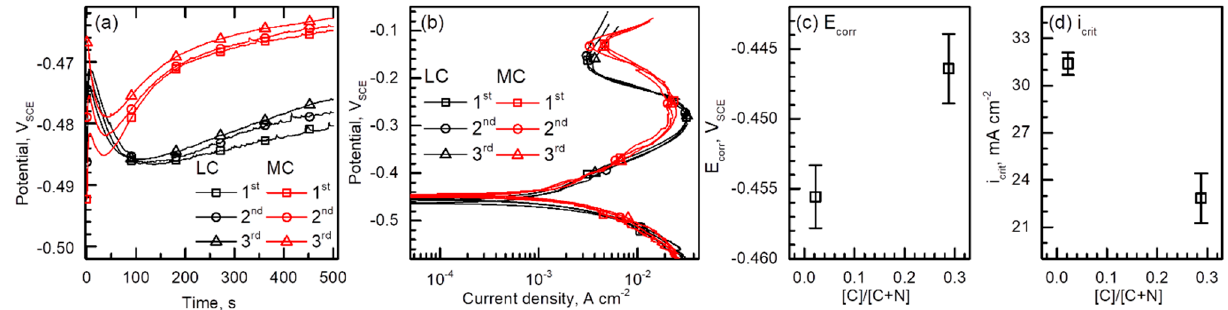
Figure 13. ( a ) Corrosion potential ( E corr ) versus time curves of the LC and MC samples measured in a 1 M HCl solution at 25 °C. ( b ) Potentiodynamic polarization curves of the two samples measured in the same solution with a potential sweep rate of 0.167 mV s − 1 . Average ( c ) E corr and ( d ) Critical anodic current density ( i crit ) values of the samples, which were obtained from 8–10 repeated polarization tests.